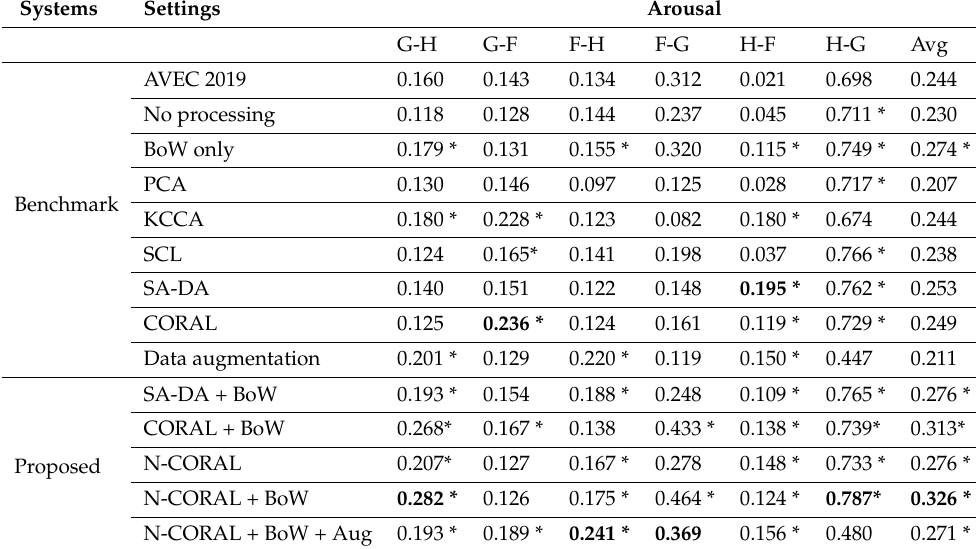
Table 2. Performance comparison of arousal estimation with different explored schemes in terms of CCC. Bi-LSTM regression was used for all methods. Highest values are indicated in bold, and significantly better results relative to benchmark are highlighted by an asterisk.